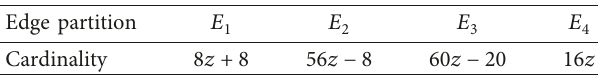
Table 4: The partition of the edge set of ( TM − TCNB ) 1